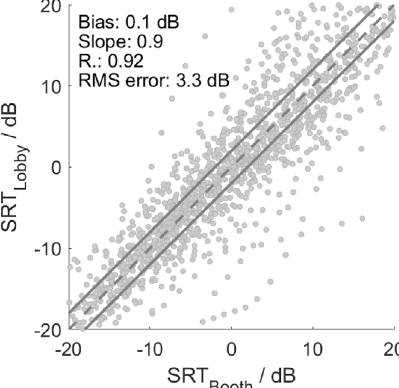
Figure 8. Comparison of the estimated SNR for each step of the ACALES scale (1 – 13, effortless – extreme effort) between the measurements in the lobby and the booth for each condition (unprocessed, IBM, BMVDR-N) and each subject. Solid lines represent a corridor of ±2 dB around the